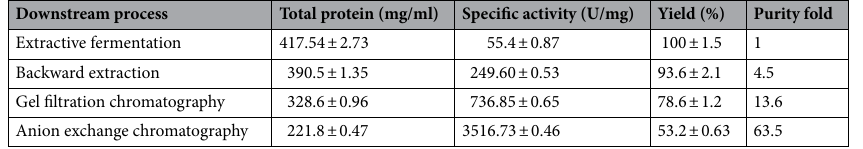
Table 3. Increase in purity fold and corresponding to various unit operations involved in the purification of naringinase (n = 3, mean represented along with standard deviation) (p < 0.05).